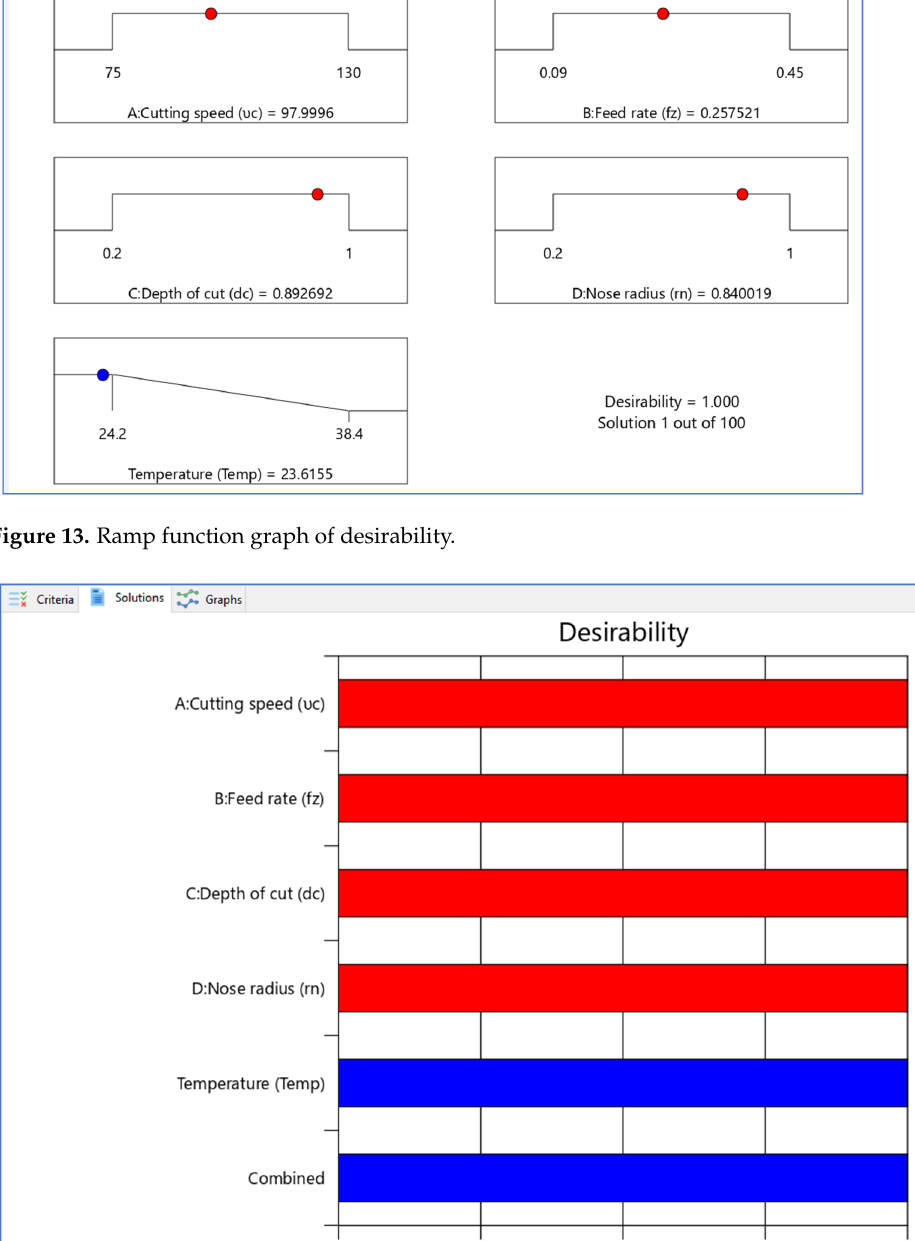
Figure 14. Bar graph of desirability.